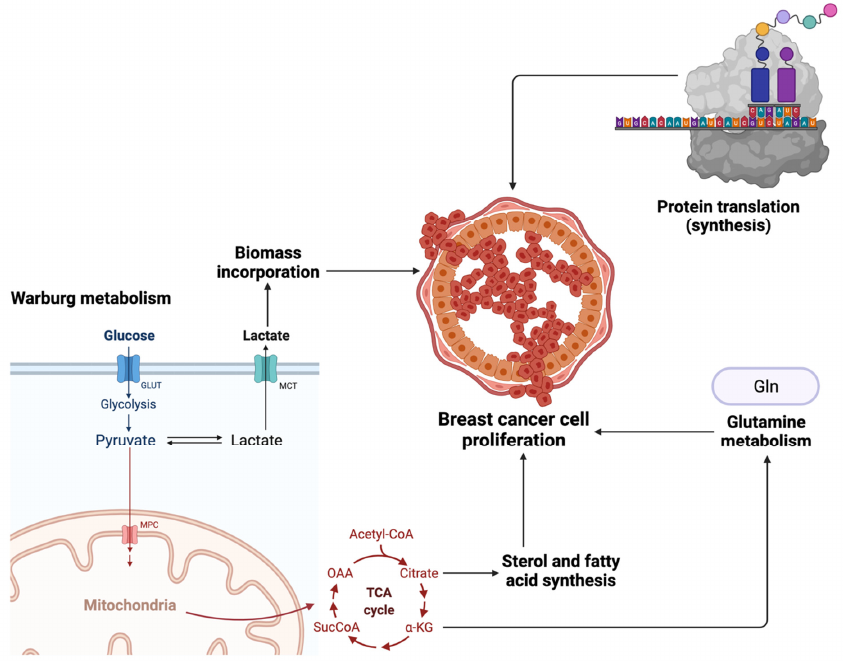
Figure 5. The multiple proposed metabolic processes involved in breast cancer cell proliferation, including the Warburg metabolism theory, sterol and fatty acid synthesis, glutamine metabolism, and protein translation.